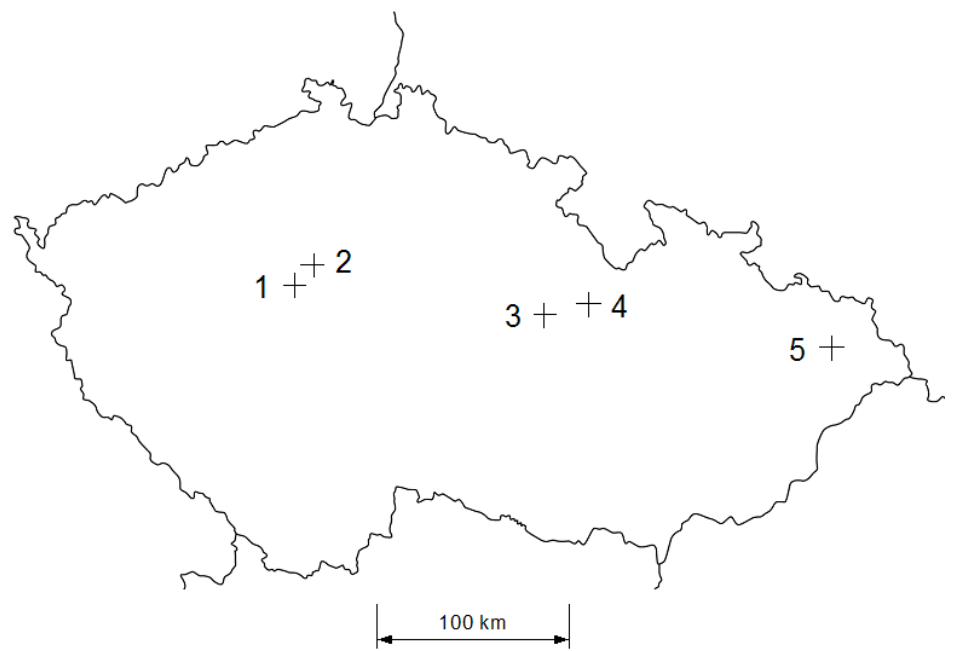
Figure 1. Cities included in the